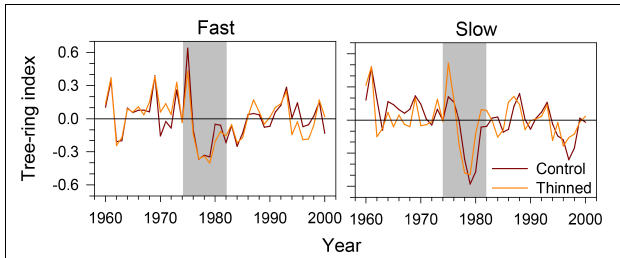
FIGURE 3 | Tree-ring index of fast- and slow-growing black spruce trees during the spruce budworm outbreak in the Saguenay-Lac-Saint-Jean region (QC, Canada). Gray area represents the 8-year period considered by the successive analyses.